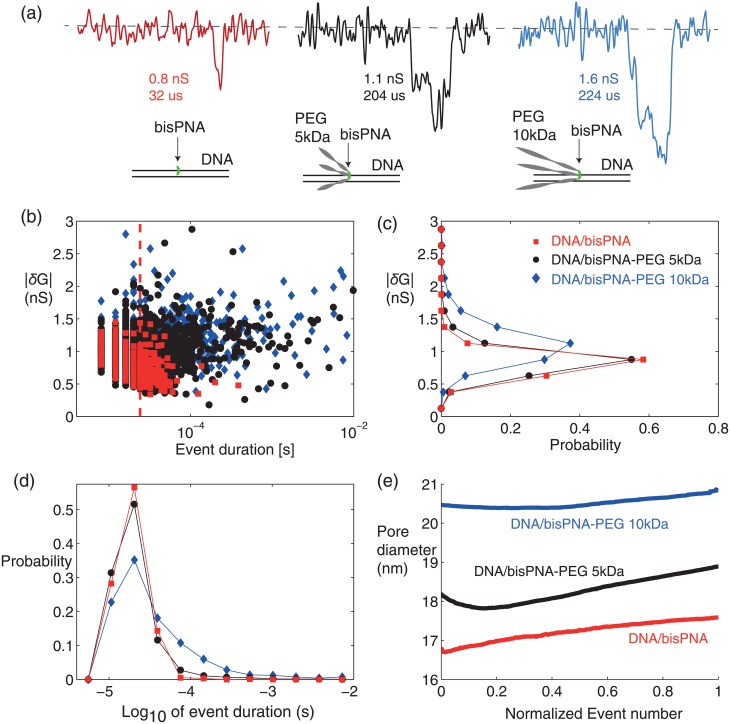
A single bisPNA on DNA is resolvable with a 17-21 nm pore by adding bulk through bisPEG-PNA linking.(a) Representative events: DNA/bisPNA (left), and DNA/bisPNA-PEG with up to 3 PEGs on each PNA, and PEG sized 5 kDa (middle) and 10 kDa (right). Molecule depictions show linear PEG and DNA sized to scale for visual comparison. (b) Population of δG vs. duration for all events in each data set, each at 2 nM and 100 mV in 1 M LiCl, with δG histogram (c) and duration histogram (d) shifted by adding PEGs of increasing size. (e) Evolution of the modeled nanopore diameter, using the time history of the open channel conductance (S2 Section), spanning 30 min (DNA/bisPNA), 58 minutes (DNA/bisPNA-PEG 5 kDa) and 40 minutes (DNA/bisPNA-PEG 10 kDa).